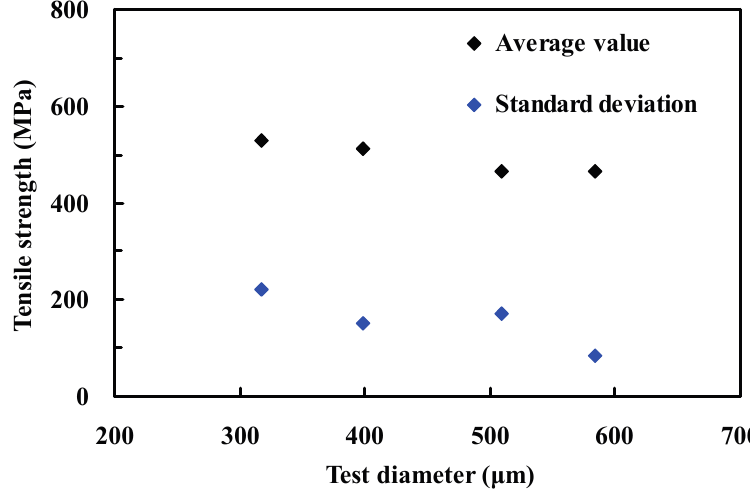
Figure 7. Tensile strength of bamboo fiber as a function of test